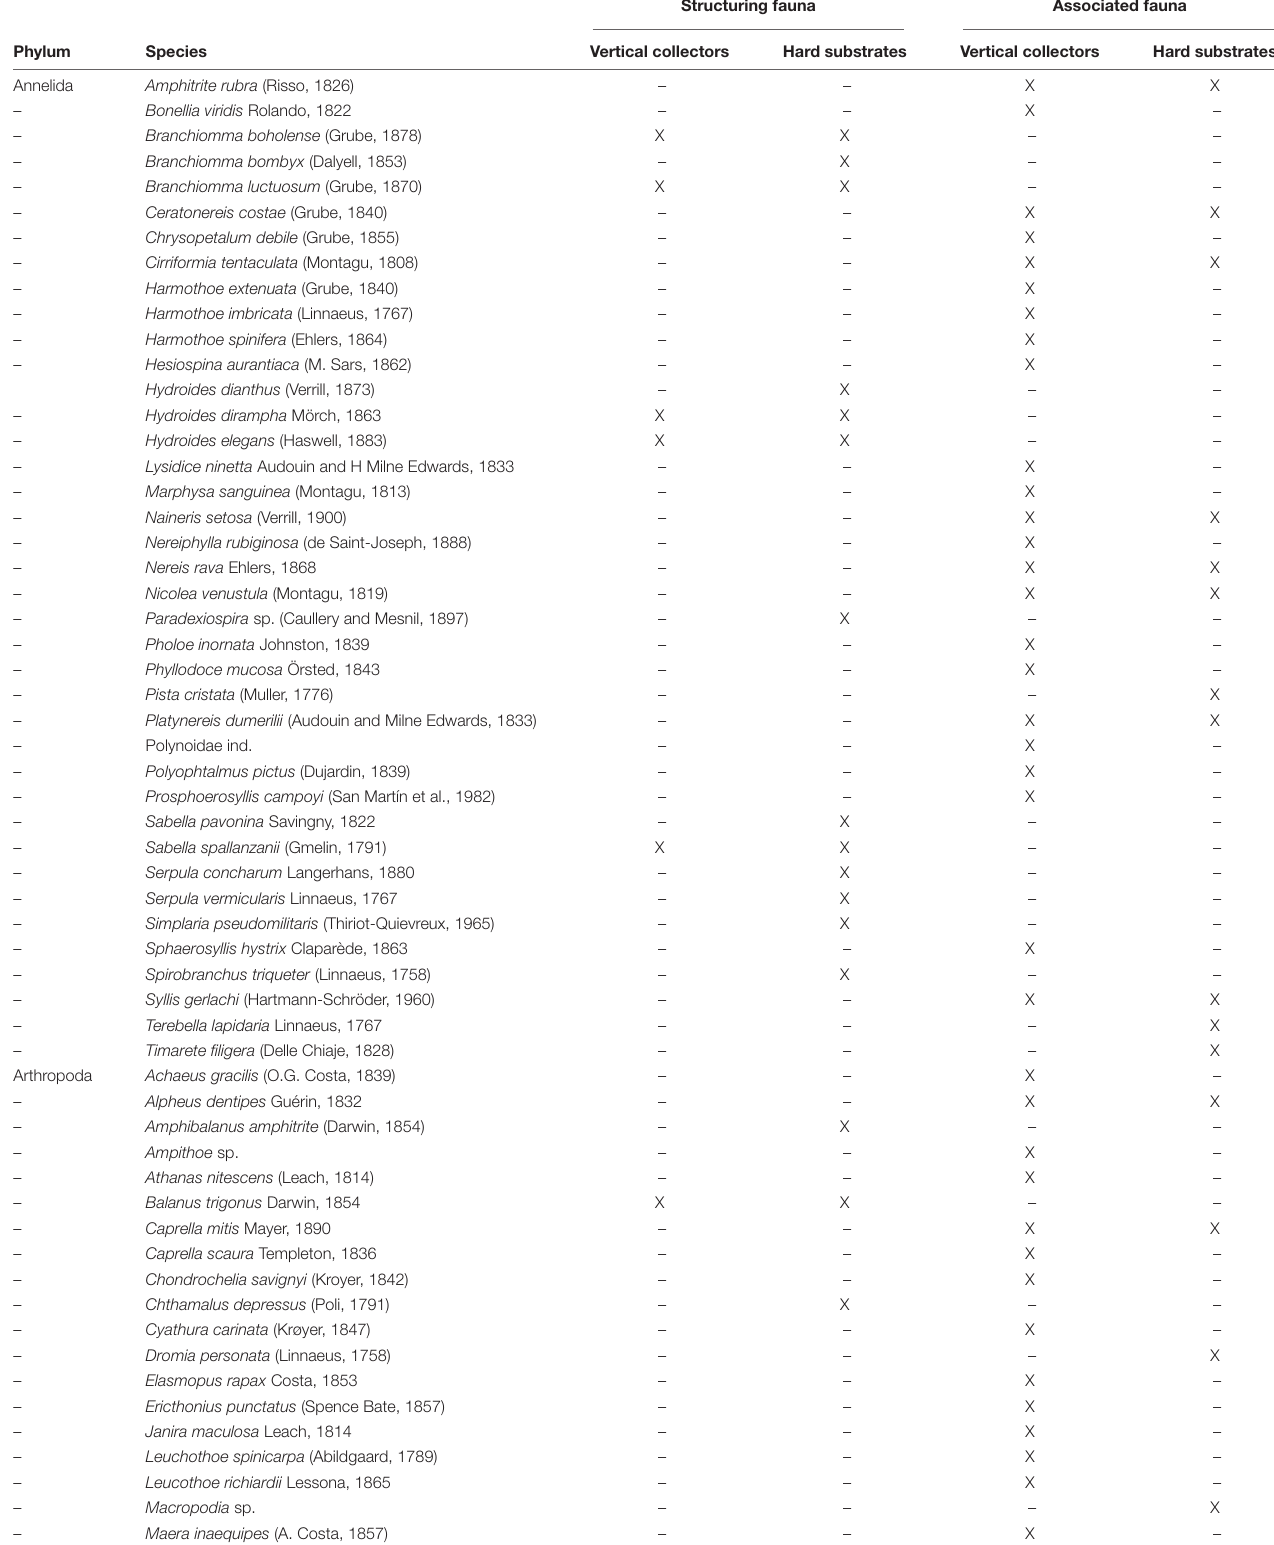
TABLE 4 | List of the species identified on the artificial